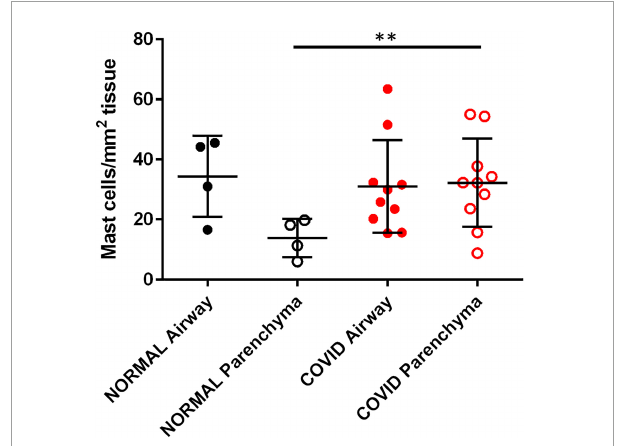
FIGURE5 SARS-Cov-2 infection increases lung parenchymal mast cells. Cadaveric lungs from patients infected with SARS-CoV-2 ( n = 10) or biopsies from donor lungs tissue prior to transplant ( n = 4) were stained with the mast cell marker avidin HRP. Mast cells were quantified in parenchyma and airway walls (medium sized